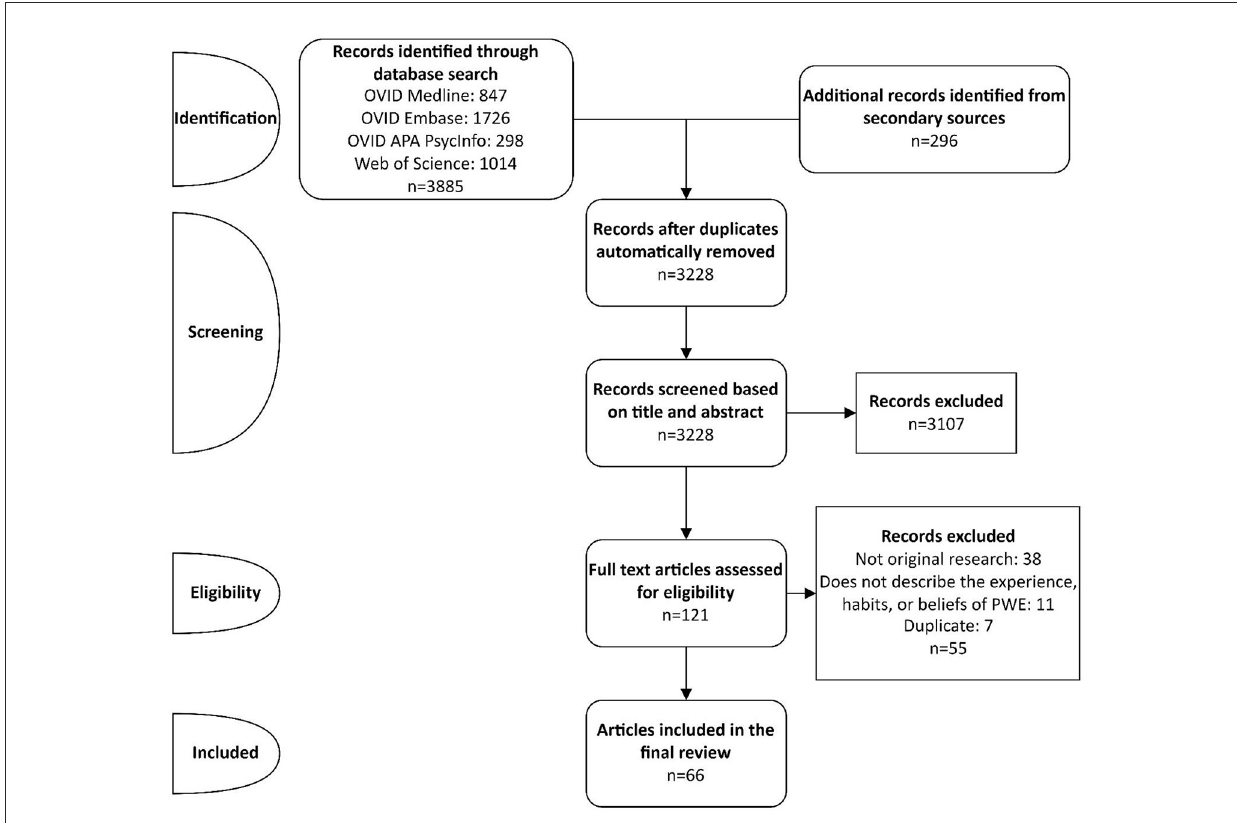
FIGURE1 Data selection